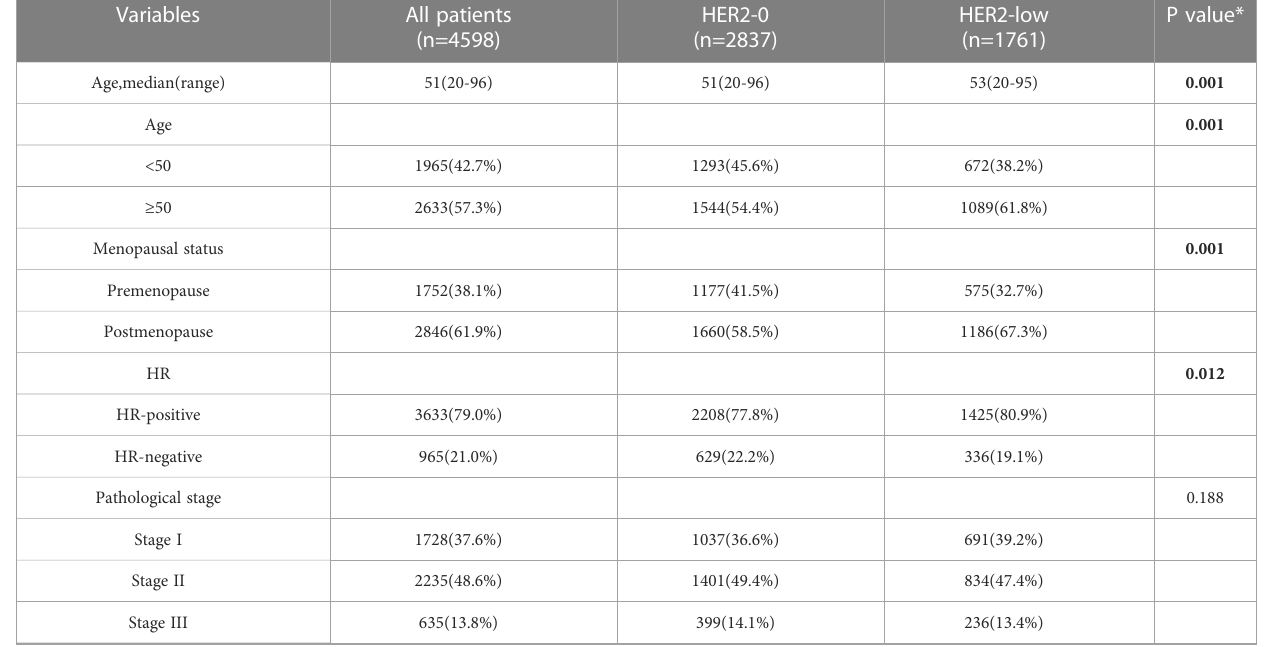
TABLE 1 Clinicopathological characteristics of patients with HER2-low breast